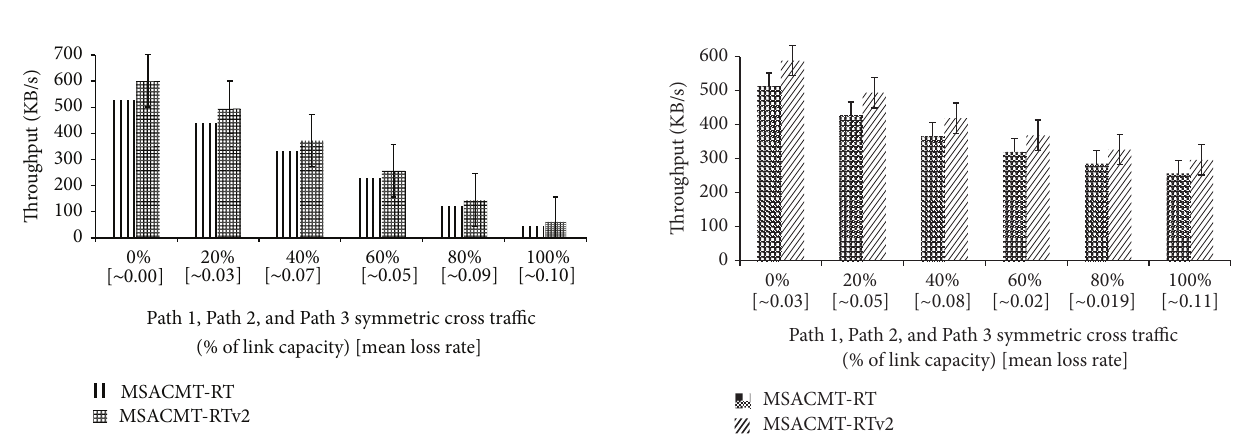
Figure 7: Asymmetric loss conditions, when Path 1 = 50% cross